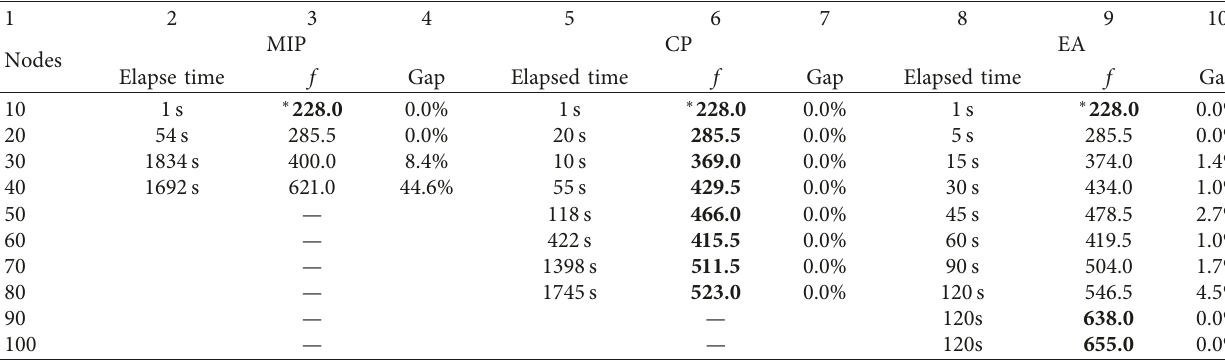
Table 2: Elapsed time and objective function value according to different job